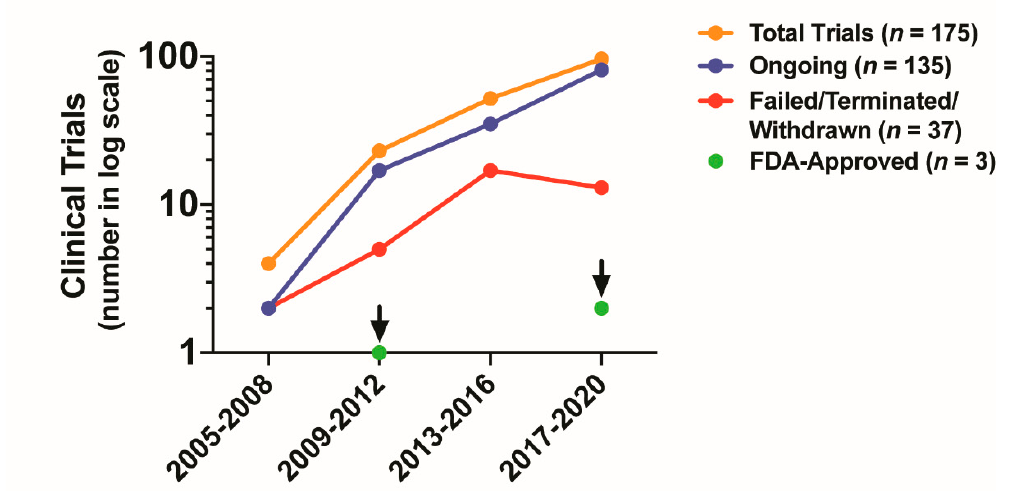
Figure 5. Account of clinical trials targeting CAFs or CAFs’ functions. The graph represents number of clinical trials (non-cumulative) targeting CAFs over time. Total number of clinical trials are indicated in orange ( n = 175), ongoing clinical trials in blue ( n = 135), failed or terminated or withdrawn trials in red ( n = 37), and FDA-approved drugs in green. Arrows indicate the time period when the trial of the FDA-approved drug was published ( n = 3)